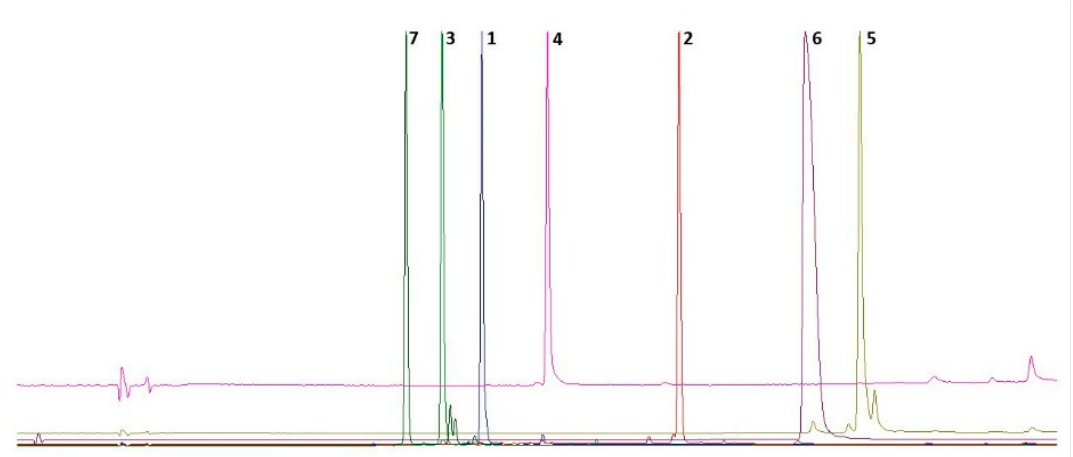
Figure 1. The exemplified overlay of chromatograms of compounds 1 – 7 at λ 254